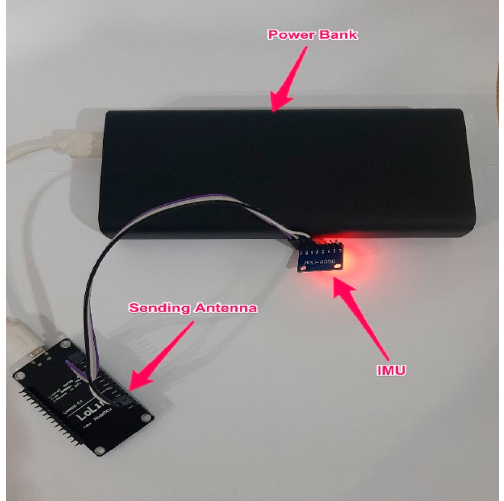
Figure 6. Sending side of the IMU system.